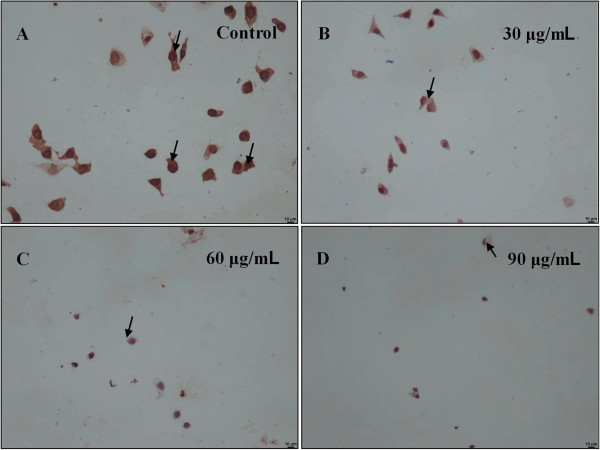
Zedoary oil downregulates PCNA protein expression in AGS cells. (A-D) Cells were treated with zedoary oil (0, 30, 60 and 90 μg/mL) for 24 h, respectively. The brown color represents positive expression of PCNA protein. The blue color represents the cell nuclei of AGS cells (200×). The control cells were AGS cells cultured in Ham’s/F-12 medium containing 10% FBS and 0.1% DMSO.